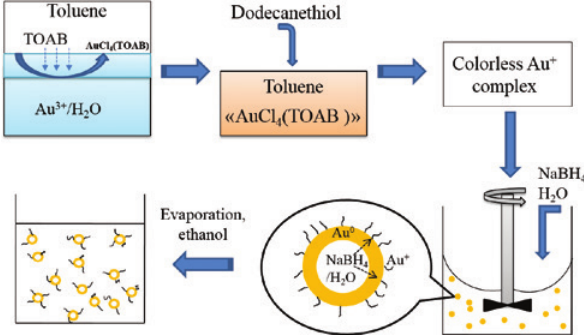
Figure 4: Emulsion process leading to gold hollow spheres. Reprinted from Ref. [64], Copyright IOP Publishing. Reproduced with permission. All rights